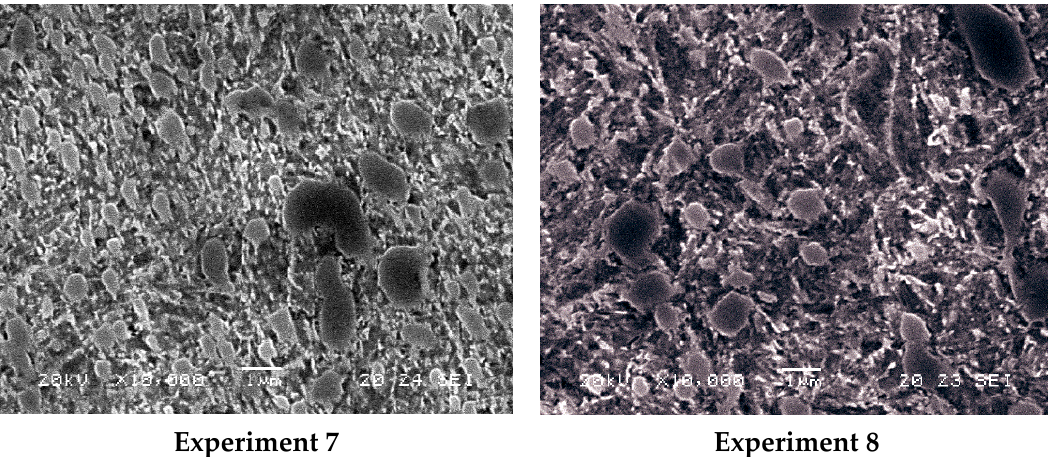
Figure 1. SEI-SEM micrographs illustrating the microstructure of all experiments. The magnification is 10,000×. M: tempered martensite; EC: eutectic carbide; SC: secondary carbide.